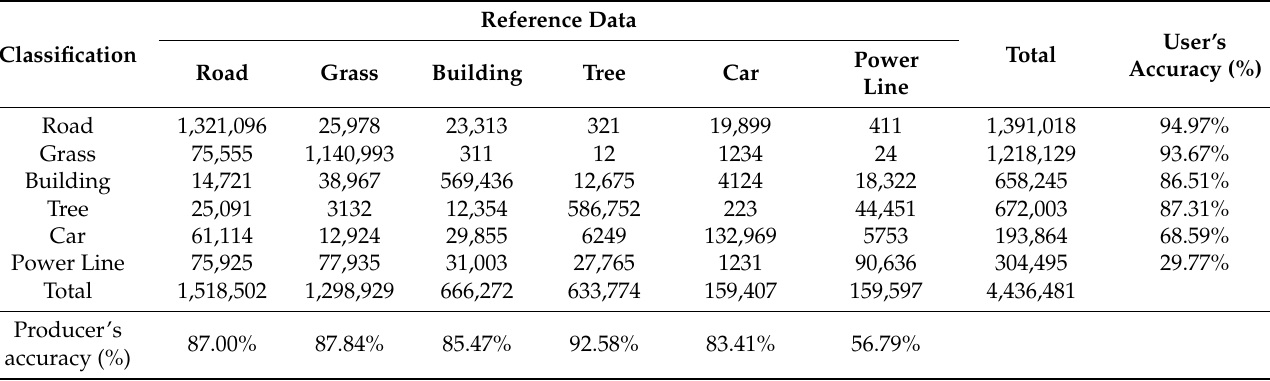
Table 6. Point cloud classification confusion matrix for method (b).